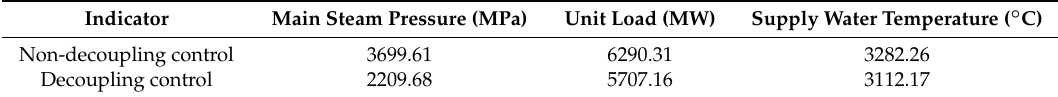
Table 4. Integrated time and absolute error (ITAE) indicator for each controlled variable.